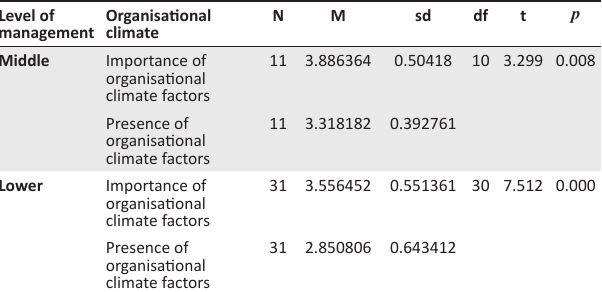
TABLE 4: Testing the difference between the level of importance and presence of organisational climate factors.